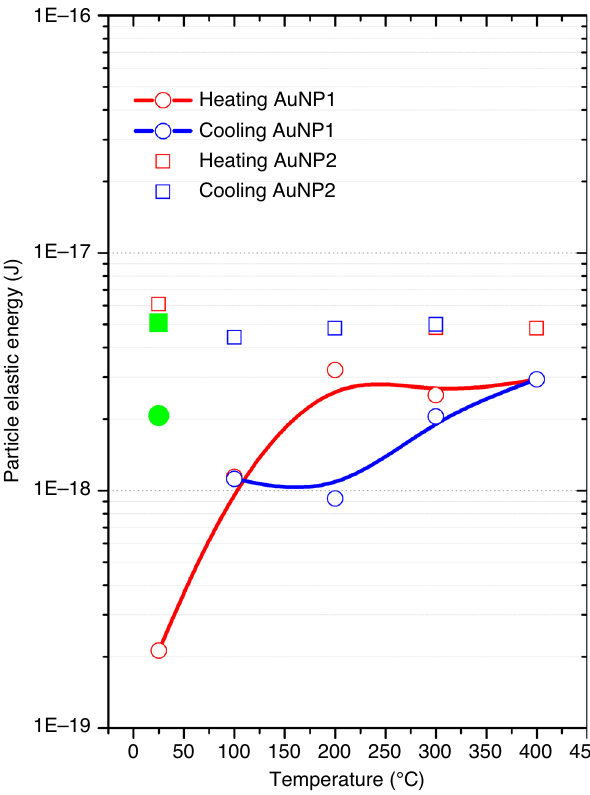
Fig. 6 Elastic energy landscape under oxidation reaction conditions. Elastic energy landscape of a single gold cuboctahedron (AuNP1, solid lines) and cube (AuNP2, symbols) nanocrystals during heating (red) and cooling (blue). The green symbols indicate the strain energy at RT after a CO oxidation cycle. Uncertainties are within the